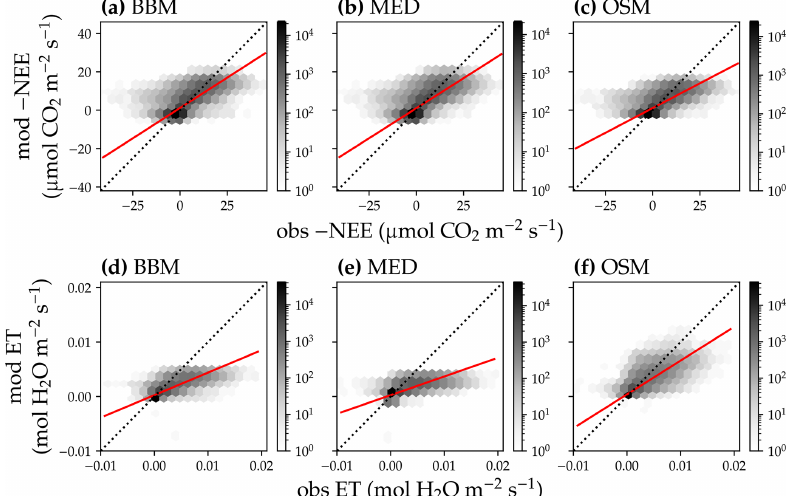
Figure 13. Comparison of half-hourly modeled and observed carbon and water fluxes for the three stomatal models for the US-MOz (MOFLUX, deciduous angiosperm forest) flux tower. (a) Comparison of modeled ( y axis) and observed ( x axis) net ecosystem carbon flux (NEE) for the Ball et al. (1987) stomatal model (BBM). Shading represents density: the darker the hexagon, the more data that fell within the hexagon. The red solid line plots the linear regression of the data, and the black dotted line plots the 1 : 1 line. (b) Comparison of NEE for the Medlyn et al. (2011) model (MED). (c) Comparison of NEE for the Wang et al. (2020) model (OSM). (d) Comparison of ecosystem water flux (ET) for the BBM. (e) Comparison of ET for the MED. (f) Comparison of ET for the